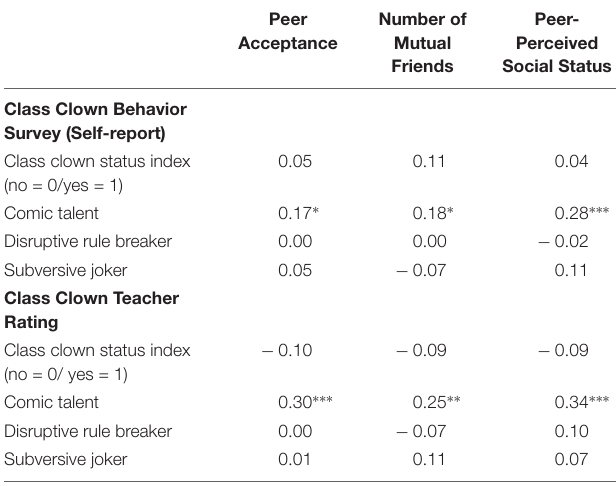
mutual friends, and peer-perceived social status (controlled for age and sex): Standardized coefficients for the fixed effects of the predictors of the respective random-intercept models for each block of predictors (self- and teacher-ratings of class clown behavior) entered